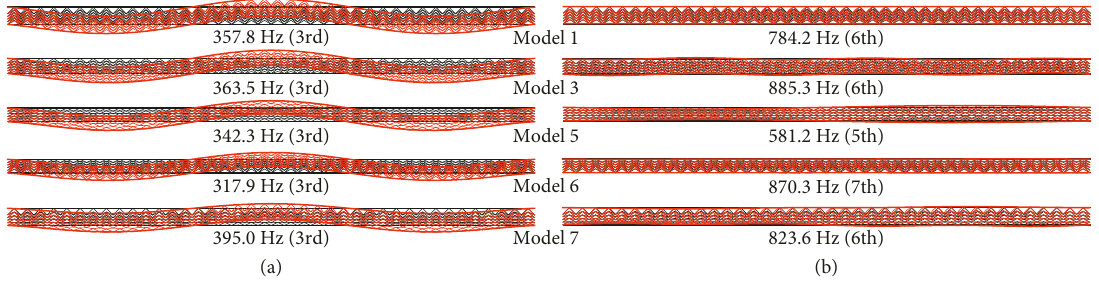
Figure 8: Vibrating mode shapes of the corresponding natural frequencies for the representative models: (a) the third bending global modes and (b) the foremost local modes.